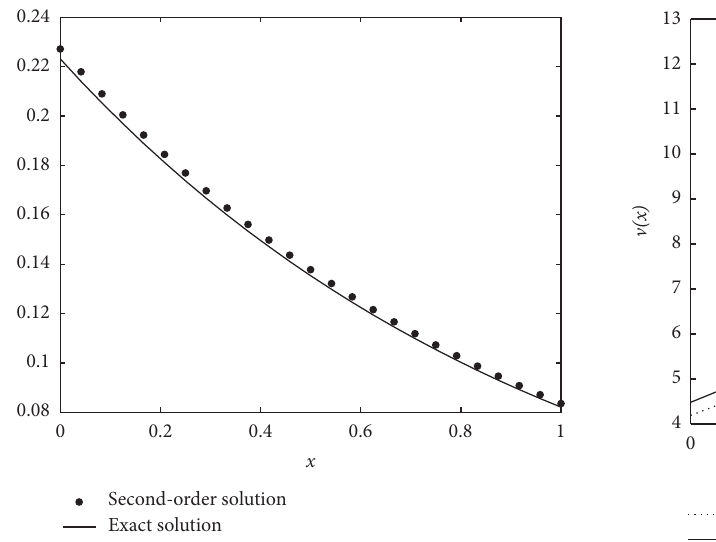
Figure 4: Convergence of first-order solution of V (𝑥,𝑦, 𝑡) at 𝑡 = 𝑦 = 1 .